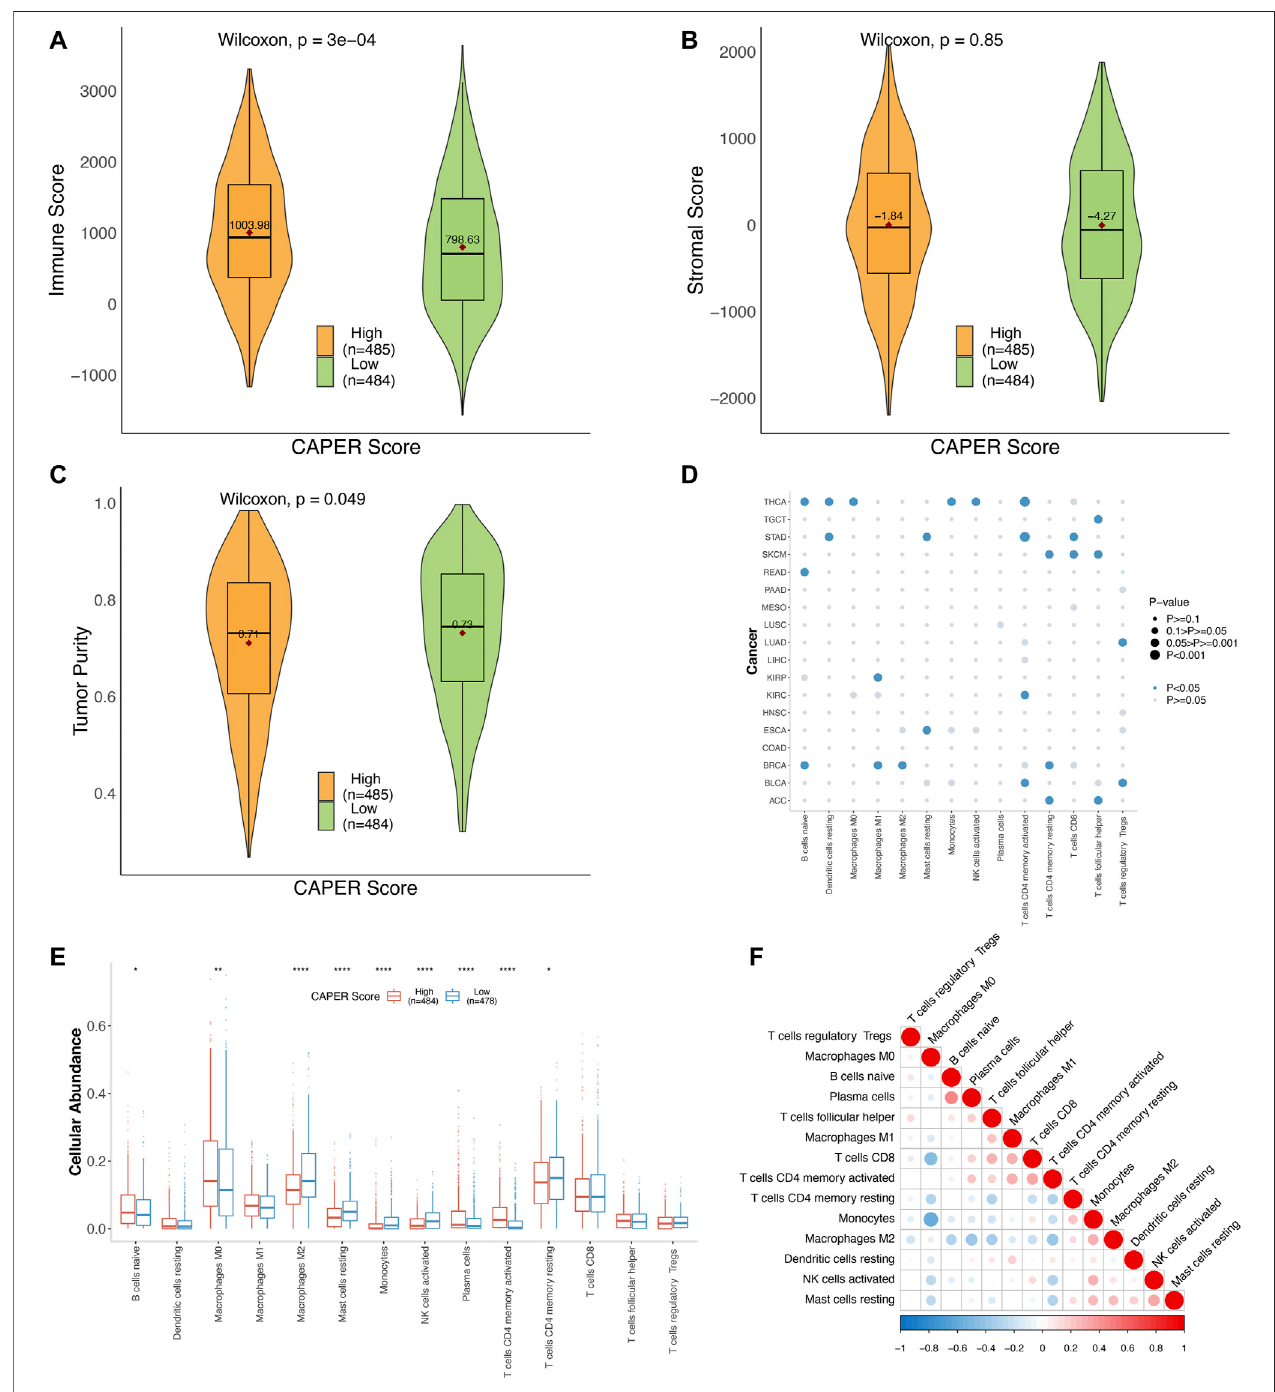
FIGURE5| Summary ofthecorrelationbetweenTME and CAPER score orCAPER geneexpression using theTCGA test set. (A) Differences in theimmunescore between the CAPER score groups. (B) Differences in the stromal score between the CAPER score groups. (C) Differences in tumor purity between the CAPER score groups. (D) The bubble plot shows the p -value of Spearman correlation tests conducted on 18 types of cancer. (E) The boxplot cellular abundance differential score between the high- and low-CAPER score groups (* p < 0.05, ** p < 0.01, and *** p < 0.001). (F) The autocorrelation plot of cellular abundance.